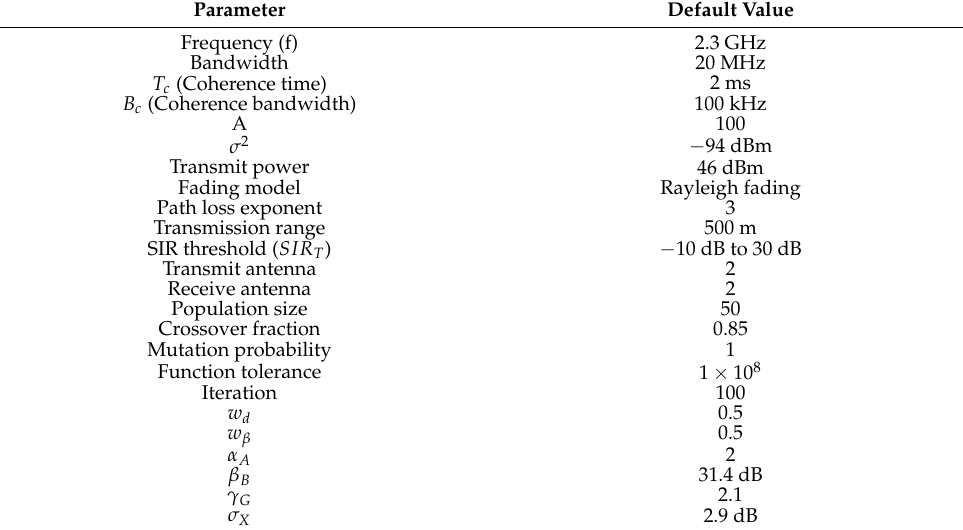
Table 2. Parameter specification.